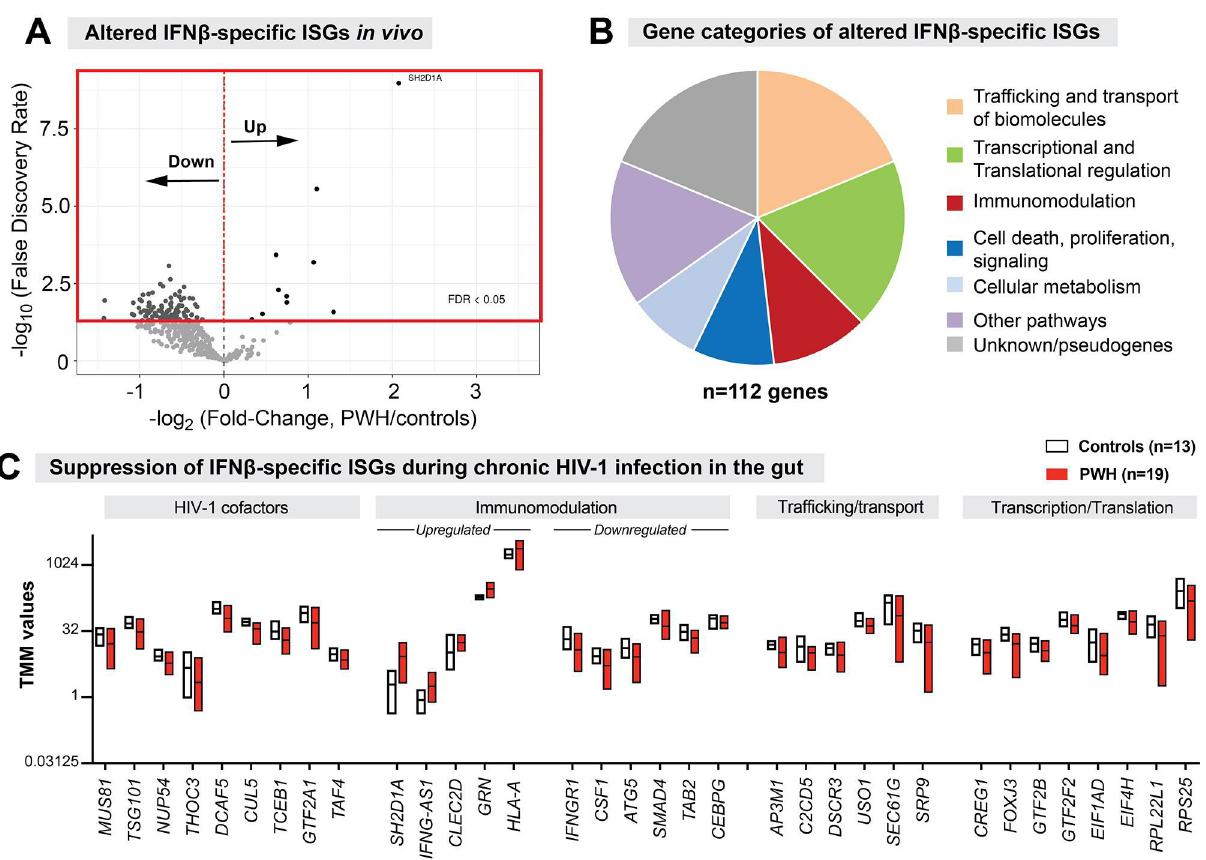
Fig 7. Inversion of IFN β -specific ISGs during chronic HIV-1 infection in the gut. (A) Volcano Plot showing the FDR and fold-change criteria for altered IFN β -specific ISGs. Majority of the IFN β -specific ISGs were downregulated in PWH relative to HIV-uninfected controls. (B) Gene categories of altered IFN β -specific ISGs. (C) TMM values of representative HIV-1 cofactors as well as immunomodulatory, trafficking/transport and transcriptional/ translational regulation genes. Floating bars correspond to min and max values, with the central line corresponding to the mean.